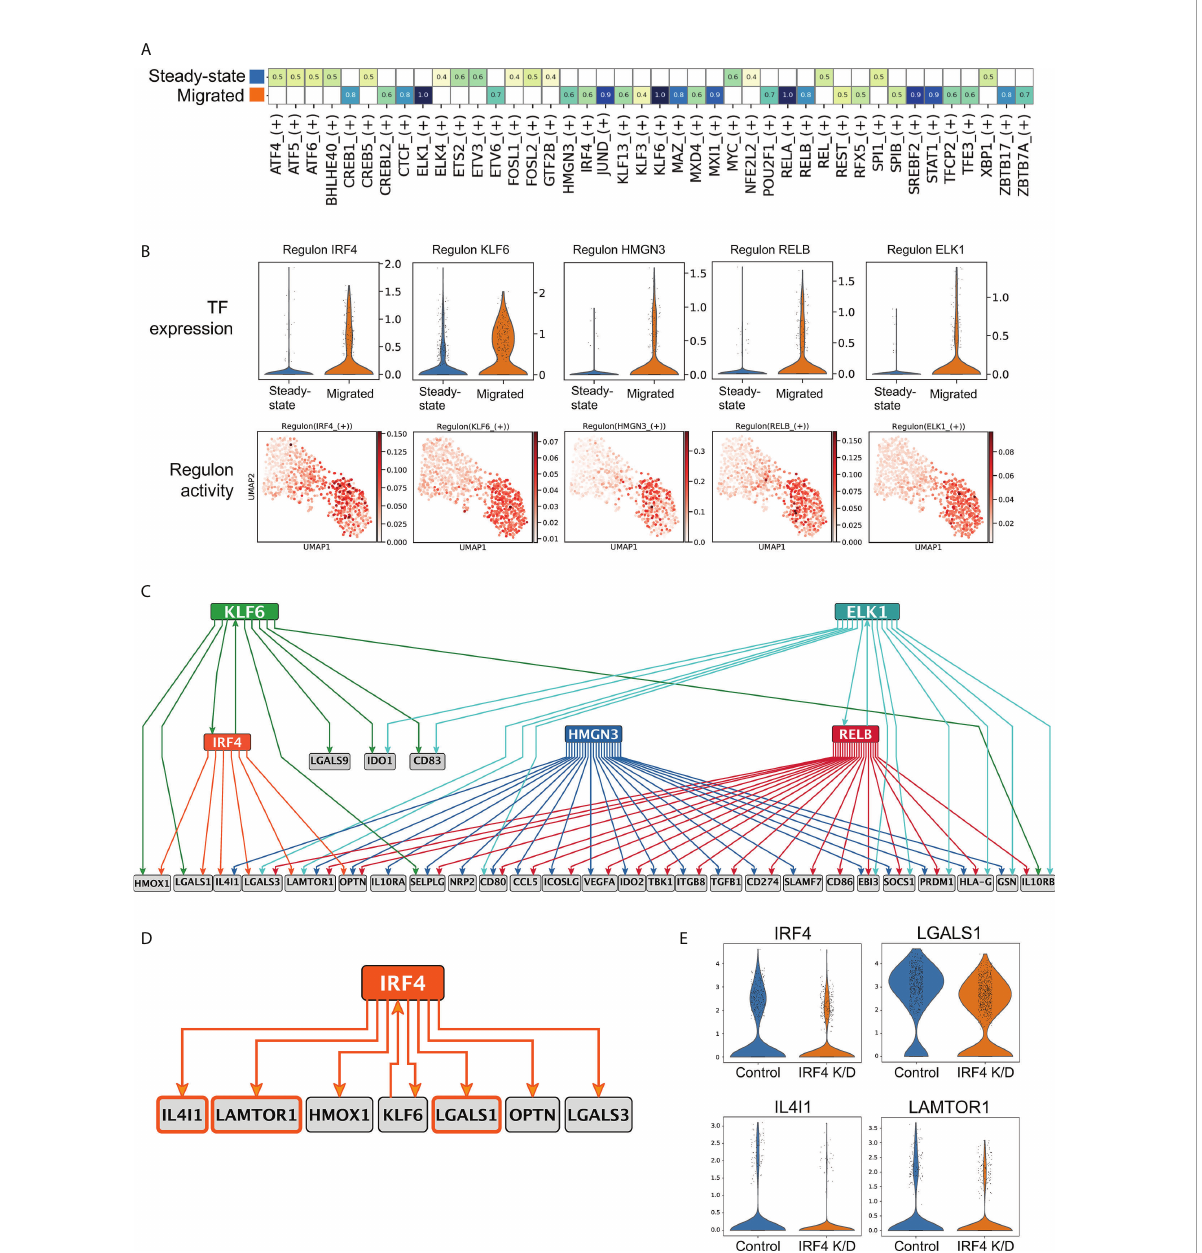
FIGURE 4 Transcriptional network underlying LC immunoregulatory programming. (A) SCENIC regulatory network and inference clustering analysis revealed TF regulons which were enriched in steady-state and migrated LCs from the same donor. Z-score heatmap of enriched regulons are displayed (z- score>0.4). (B) Violin plots displaying the transcriptomic expression of TFs identi fi ed to be enriched in migrated LCs from SCENIC analysis. UMAP marker plots showing TF regulon enrichment Z-scores in each cell, across the two LC populations are displayed. (C) PIDC network graph comprising 70 edges with weight >1, hierarchically organized, displaying predicted regulatory modules for the top 5 enriched TFs with genes within the tol 1 signature. (D) PIDC Network displaying IRF4 with 6 target genes and 1 transcription factor as predicted by PIDC. (E) Violin plots displaying the 3 predicted